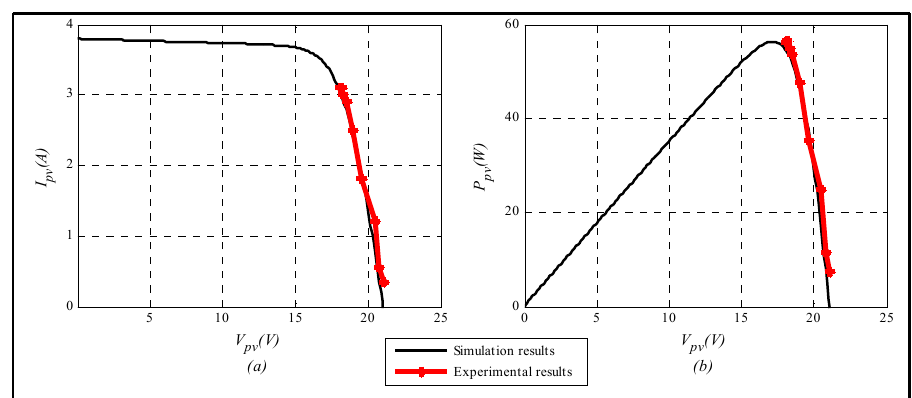
Figure 13. PV emulated characteristics using batteries under STC: ( a ) I = f(V) curve. ( b ) P = f(V) curve.